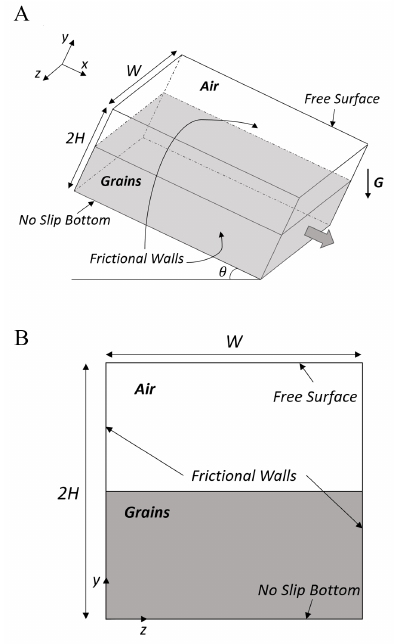
Figure 3. (A) Heap flow schematic and (B) y-z plane